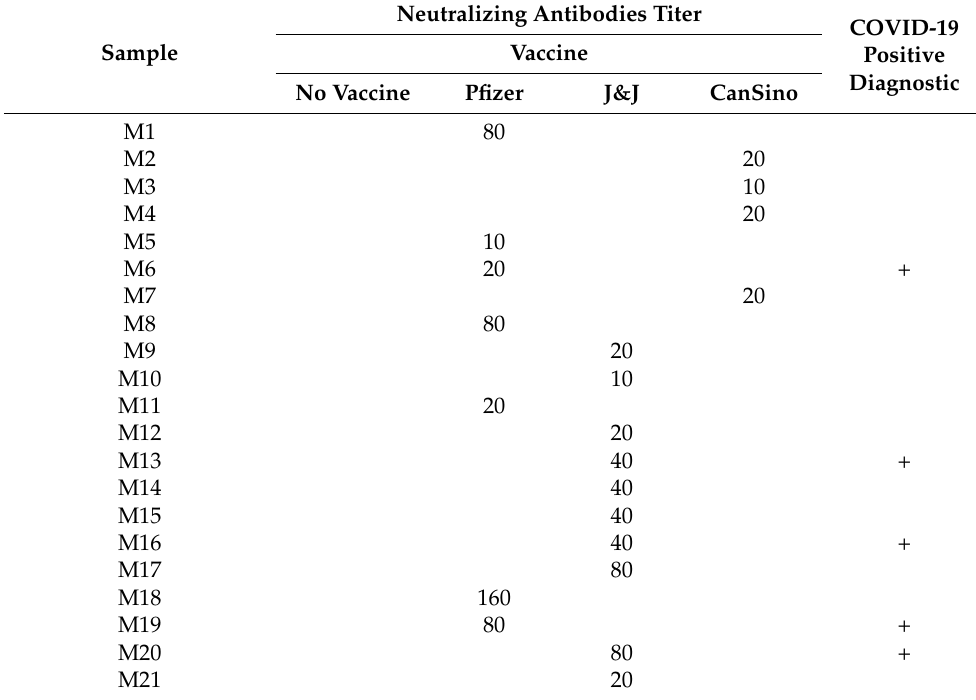
Table 1. Neutralizing Antibodies Titer for all breast milk samples. Neutralizing Antibodies Sample